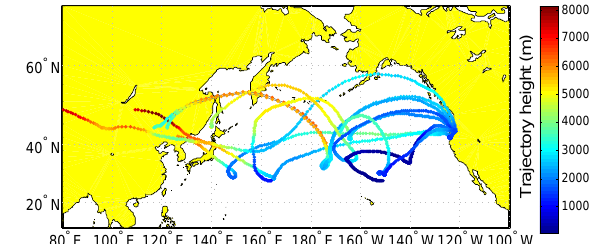
Fig. 3. Ten-day HYSPLIT airmass back trajectories for three Asian long-range transport (ALRT) high-RGM events. Trajectories were initialized at times during each event when the highest RGM/GEM- ratios were observed.